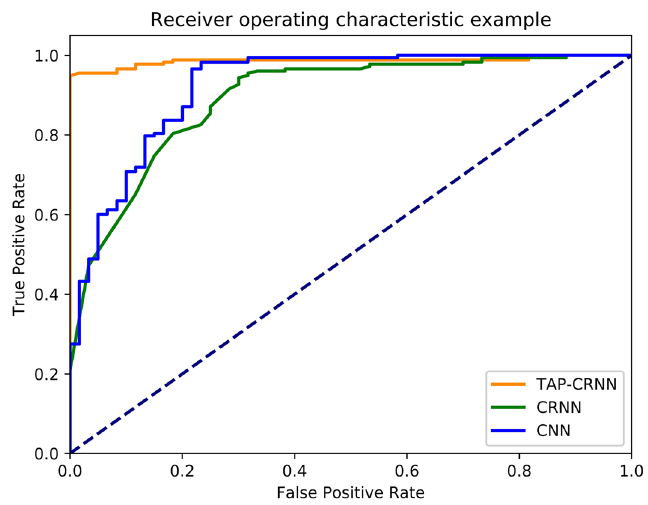
Figure 2. The experimental result of the ROC curves of the CNN, CRNN, and TAP-CRNN models.